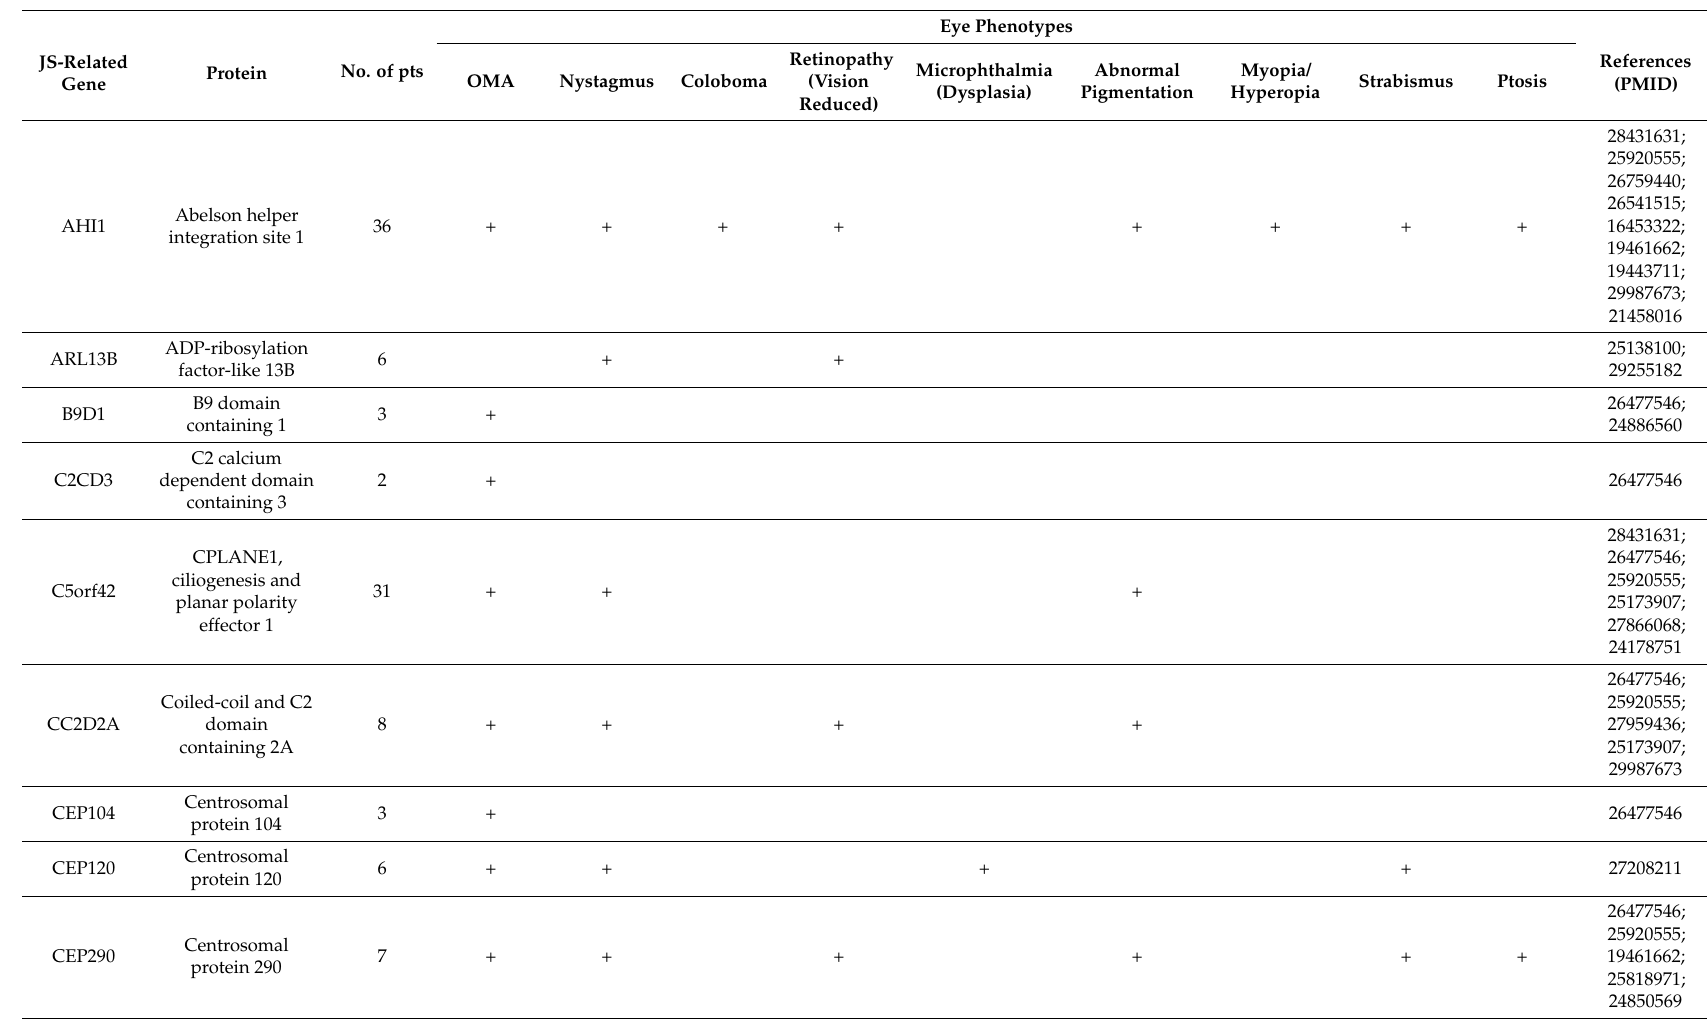
Table 1. Genes, proteins, and eye phenotypes in Joubert